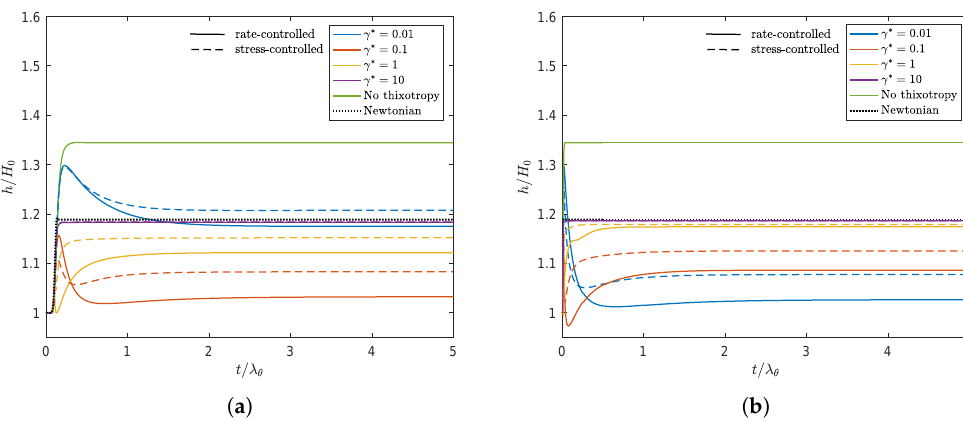
Figure 10. Swell ratio as a function of dimensionless time of the point of the free surface on Γ out for different values of γ ∗ for the rate-controlled approach and the corresponding value of τ ∗ for the stress-controlled approach. ( a ) λ θ = 10 λ avg and ( b ) λ θ = 100 λ avg . Solid lines are the rate-controlled model predictions, dashed lines are the corresponding stress-controlled model predictions. The black dashed line indicates the Newtonian swell ratio. ( a ) λ θ = 10 λ avg . ( b ) λ θ = 100 λ avg